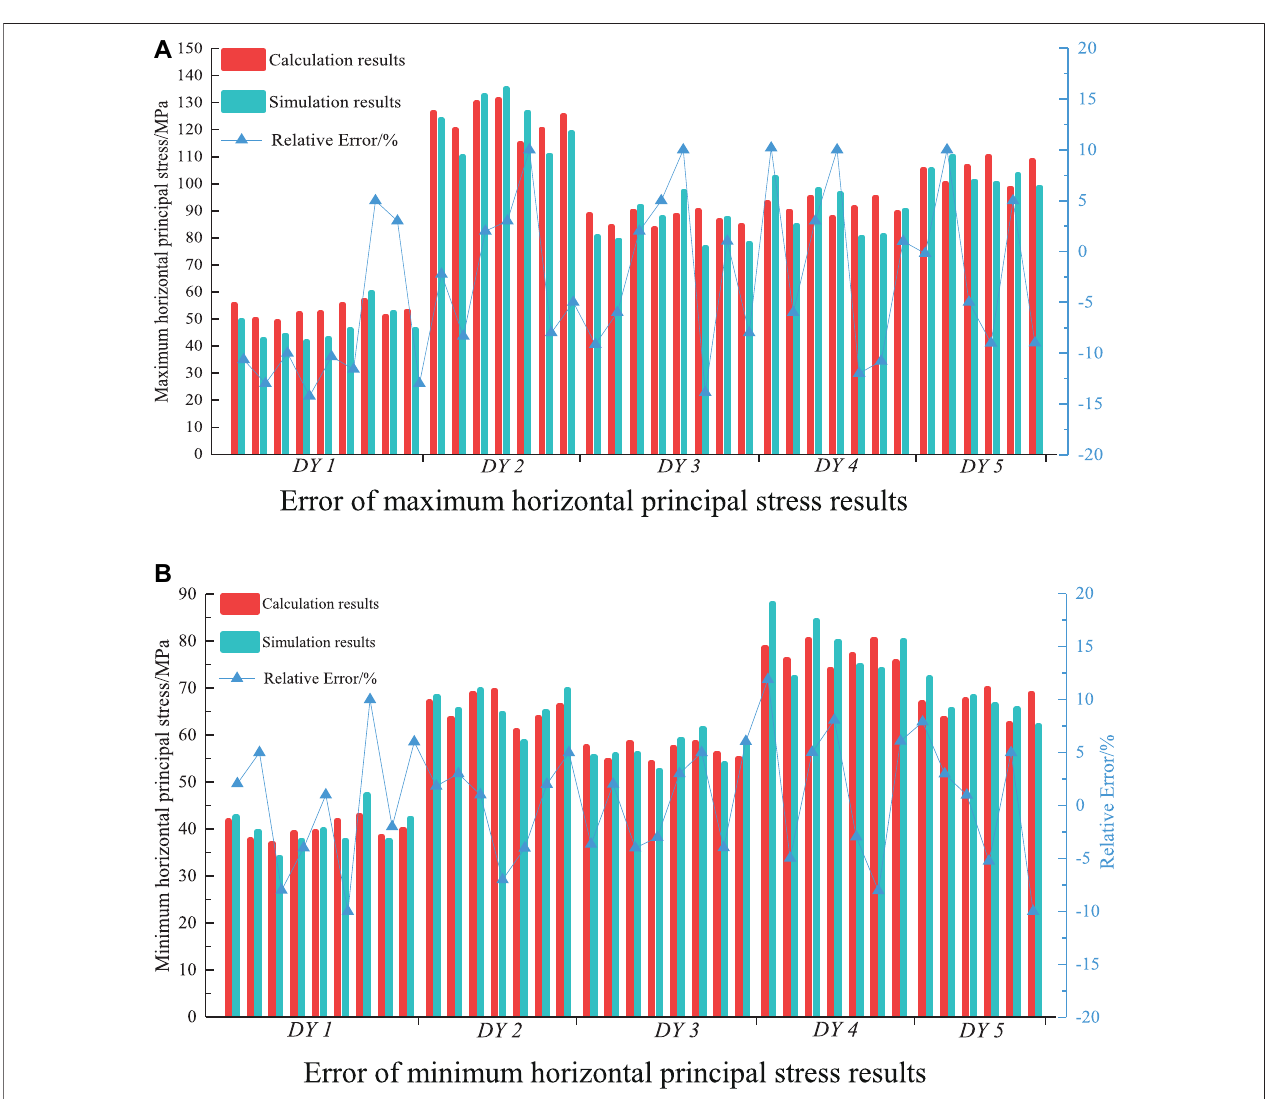
FIGURE 12 | Comparison of horizontal principal stress results based on simulation and calculation. (A) Error of maximum horizontal principal stress results. (B) Error of minimum horizontal principal stress results.